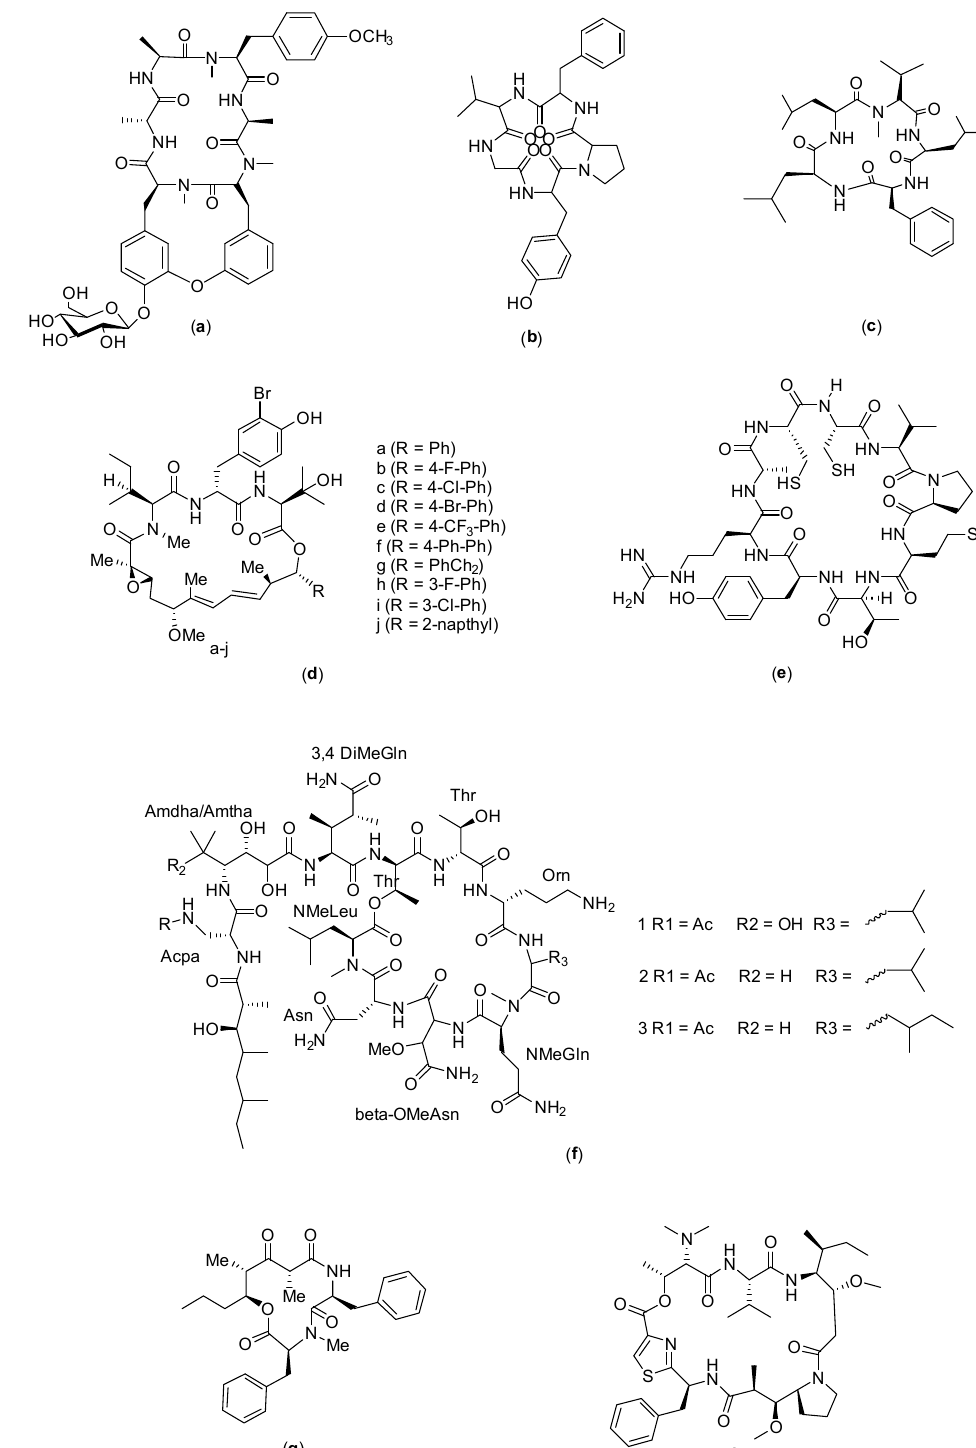
Figure 6. Structure of: ( a ) RA-XII; ( b ) Longicalcynin A; ( c ) Sansalvamide G; ( d ) Nannocystin ( e ) C25; ( f ) Theopapuamide; ( g ) Stereocalpin; and ( h ) Dol-10 cyclic.